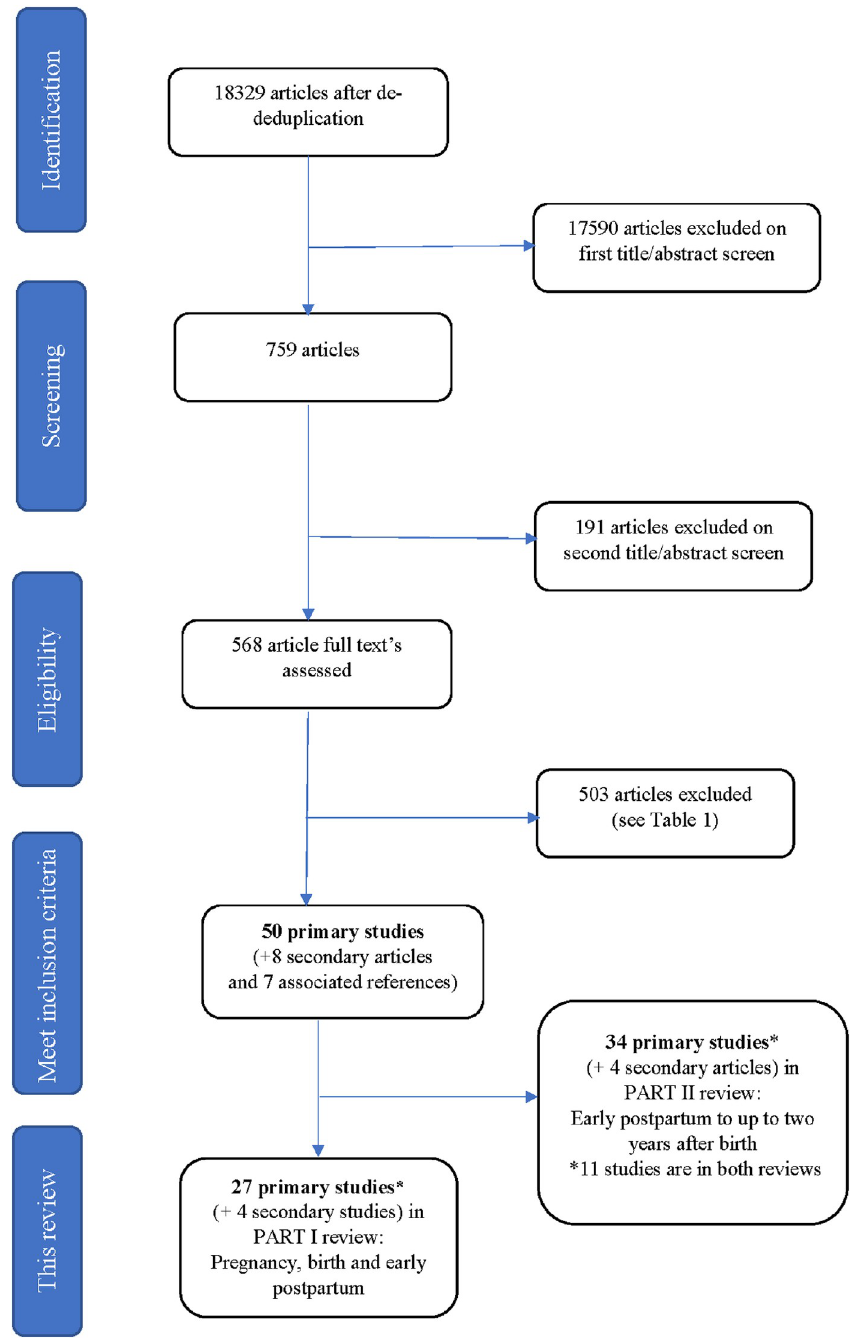
Fig 1. Flow chart of included